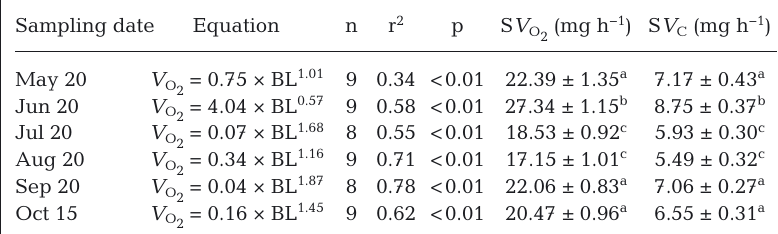
Table 3. Allometric relationship between oxygen consumption rate ( V O2 ; mg h −1 ) and body length (BL; cm), and corresponding standardized oxygen consumption rate O2 and S V C , data are presented as means ± 1 SD. Different superscript letters within each column indicate a significant difference between monthly sampling dates in 2011 (p <